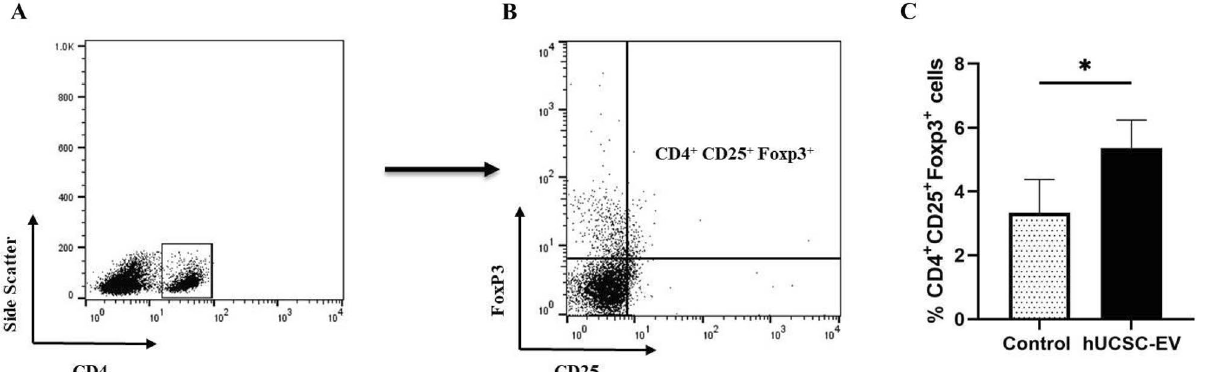
Figure 8. Frequency of CD4 + CD25 + Foxp3 + Treg cells in the spleen. CD4 + cells gated in lymphocyte gate ( A ) and CD25 + Foxp3 + cells were determined in CD4 + gate ( B ). The frequency of CD4 + CD25 + Foxp3 + Treg cells in the spleen of hUCSC-EVs-treated mice was significantly higher than EAE control mice ( C ). Data are shown as mean ± SD. *p < 0.05. hUCSC-EV human umbilical cord-derived mesenchymal stem cell-extracellular vesicle, Treg regulatory T